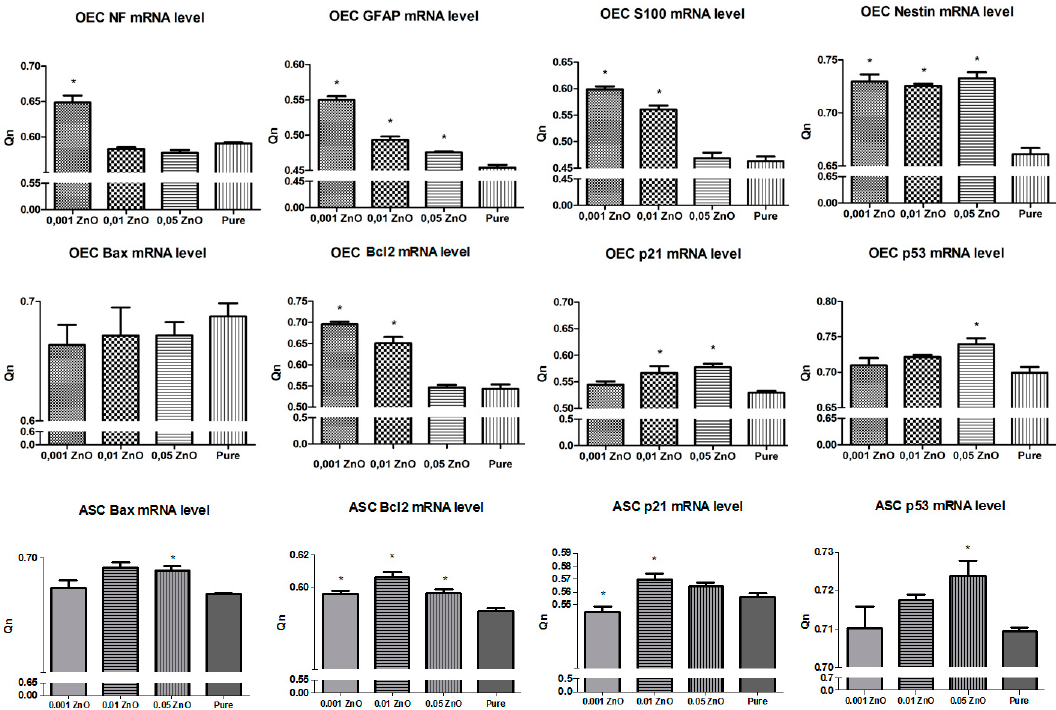
Figure 9. The real-time RT-PCR results obtained from olfactory ensheathing cells (OEC) and adipose mesenchymal stem cells (ASC); * significantly different from control ( p < 0.05).